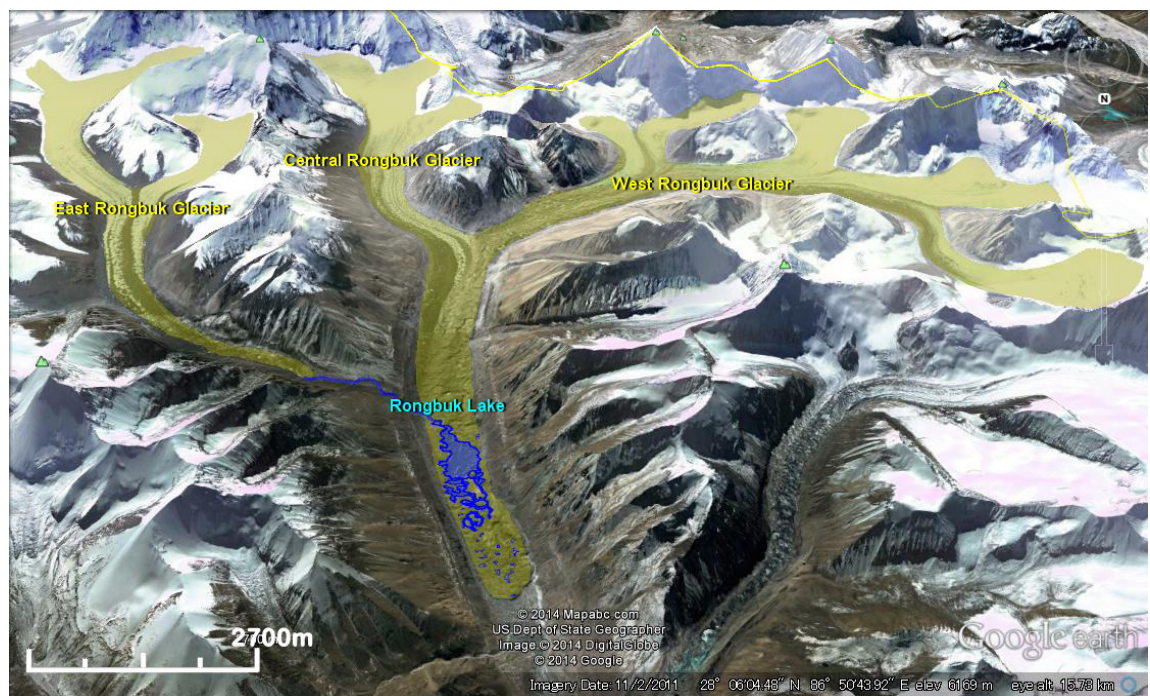
Figure 6. Rongbuk Lake and glaciers connected to Rongbuk Lake. The light yellow presents glaciers and blue presents Rongbuk Lake. (Basemap source: Google